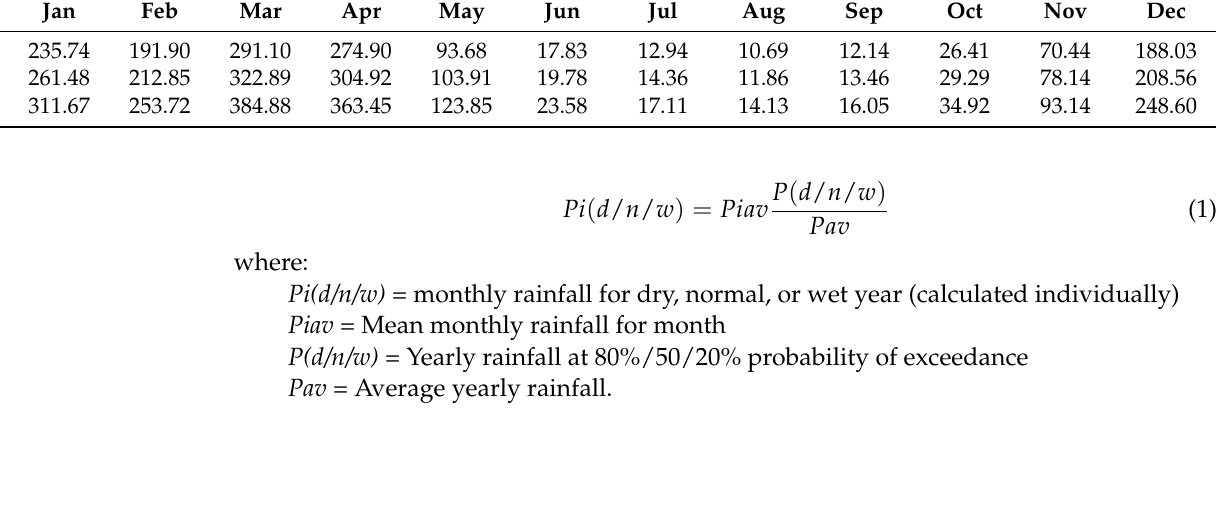
Figure 4. Monthly rainfall characteristics based on arithmetic mean between 1933–2019. Table 2. Summary of monthly rainfall values for dry, normal, and wet